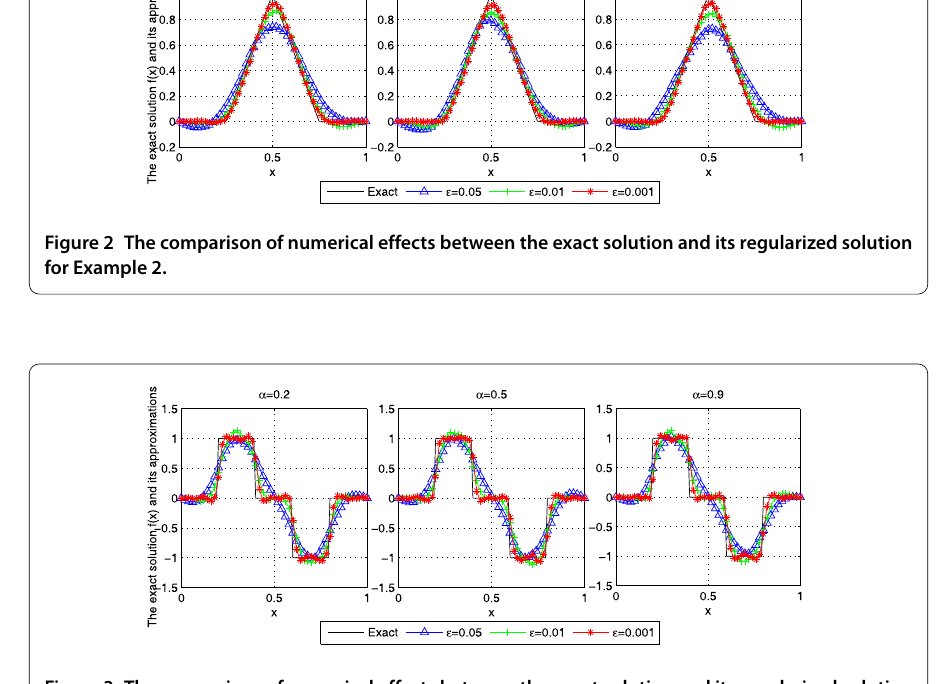
Figure 3 The comparison of numerical effects between the exact solution and its regularized solution for Example